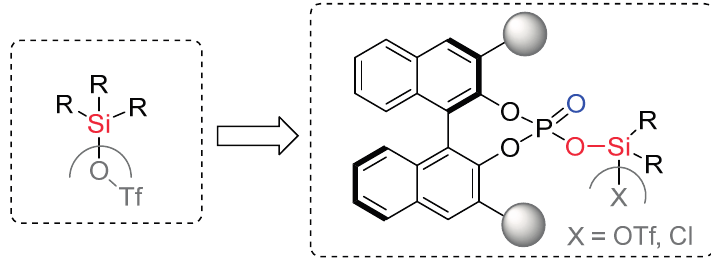
Figure 2. Design of new chiral catalyst for [3+2] cycloaddition